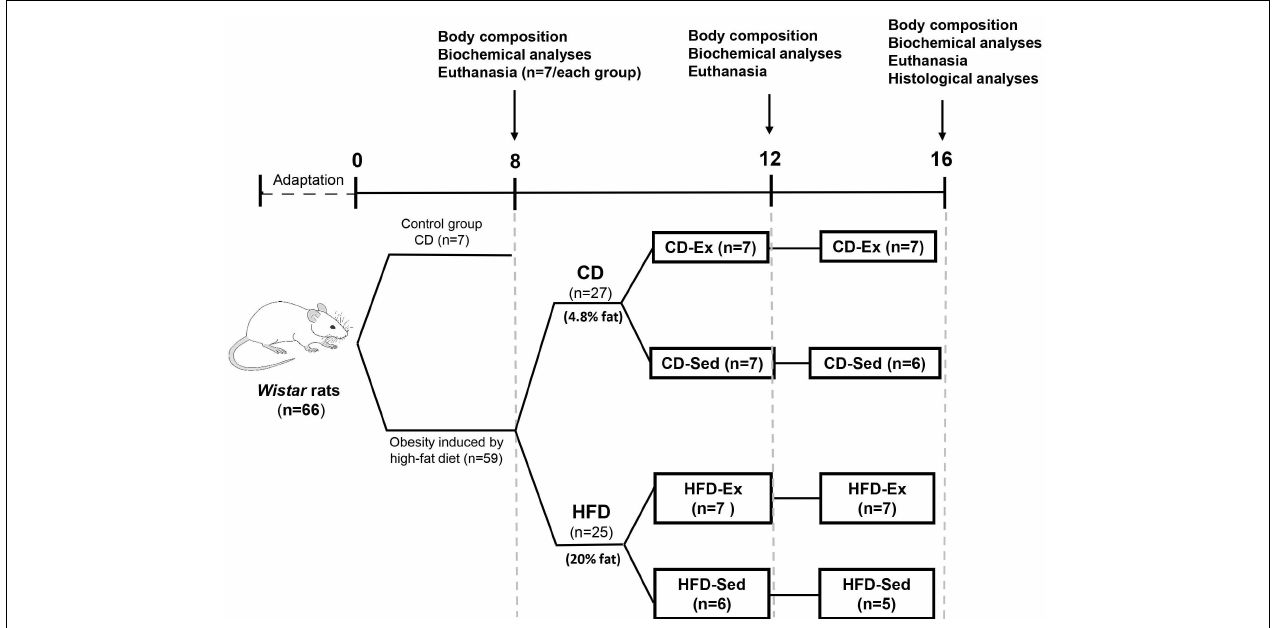
FIGURE 1 | Schematic representation of the study design. HFD: high-fat diet; CD: chow diet; HFD-Ex: high-fat diet and exercise; HFD-Sed: sedentary high-fat diet; CD-Ex: chow diet and exercise; CD-Sed: sedentary chow diet.